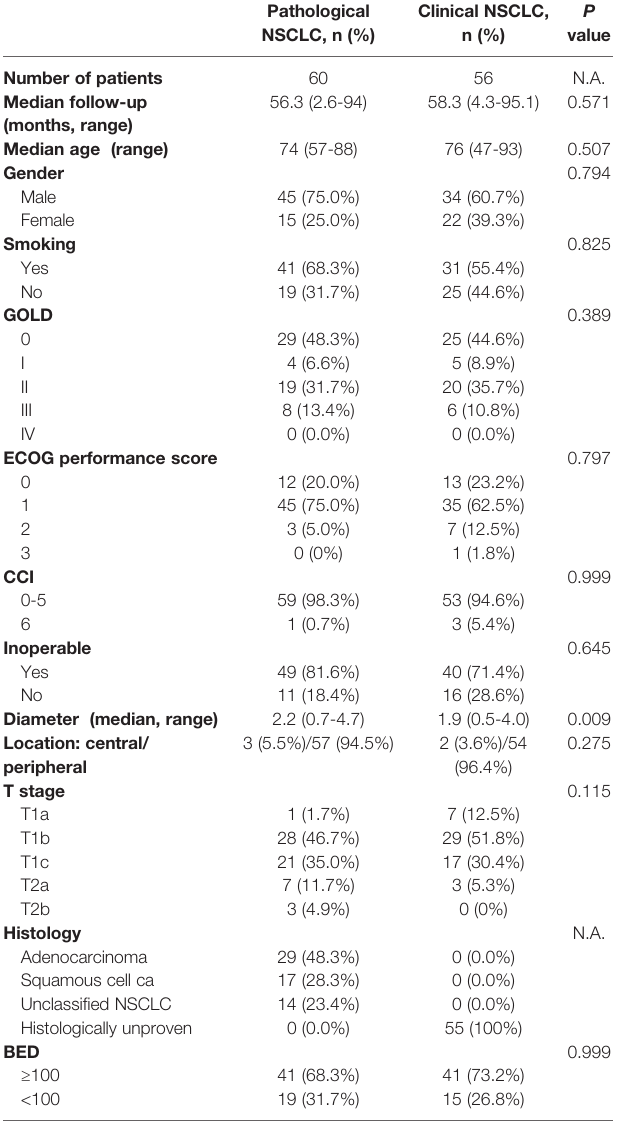
TABLE 1 | Characteristics of all